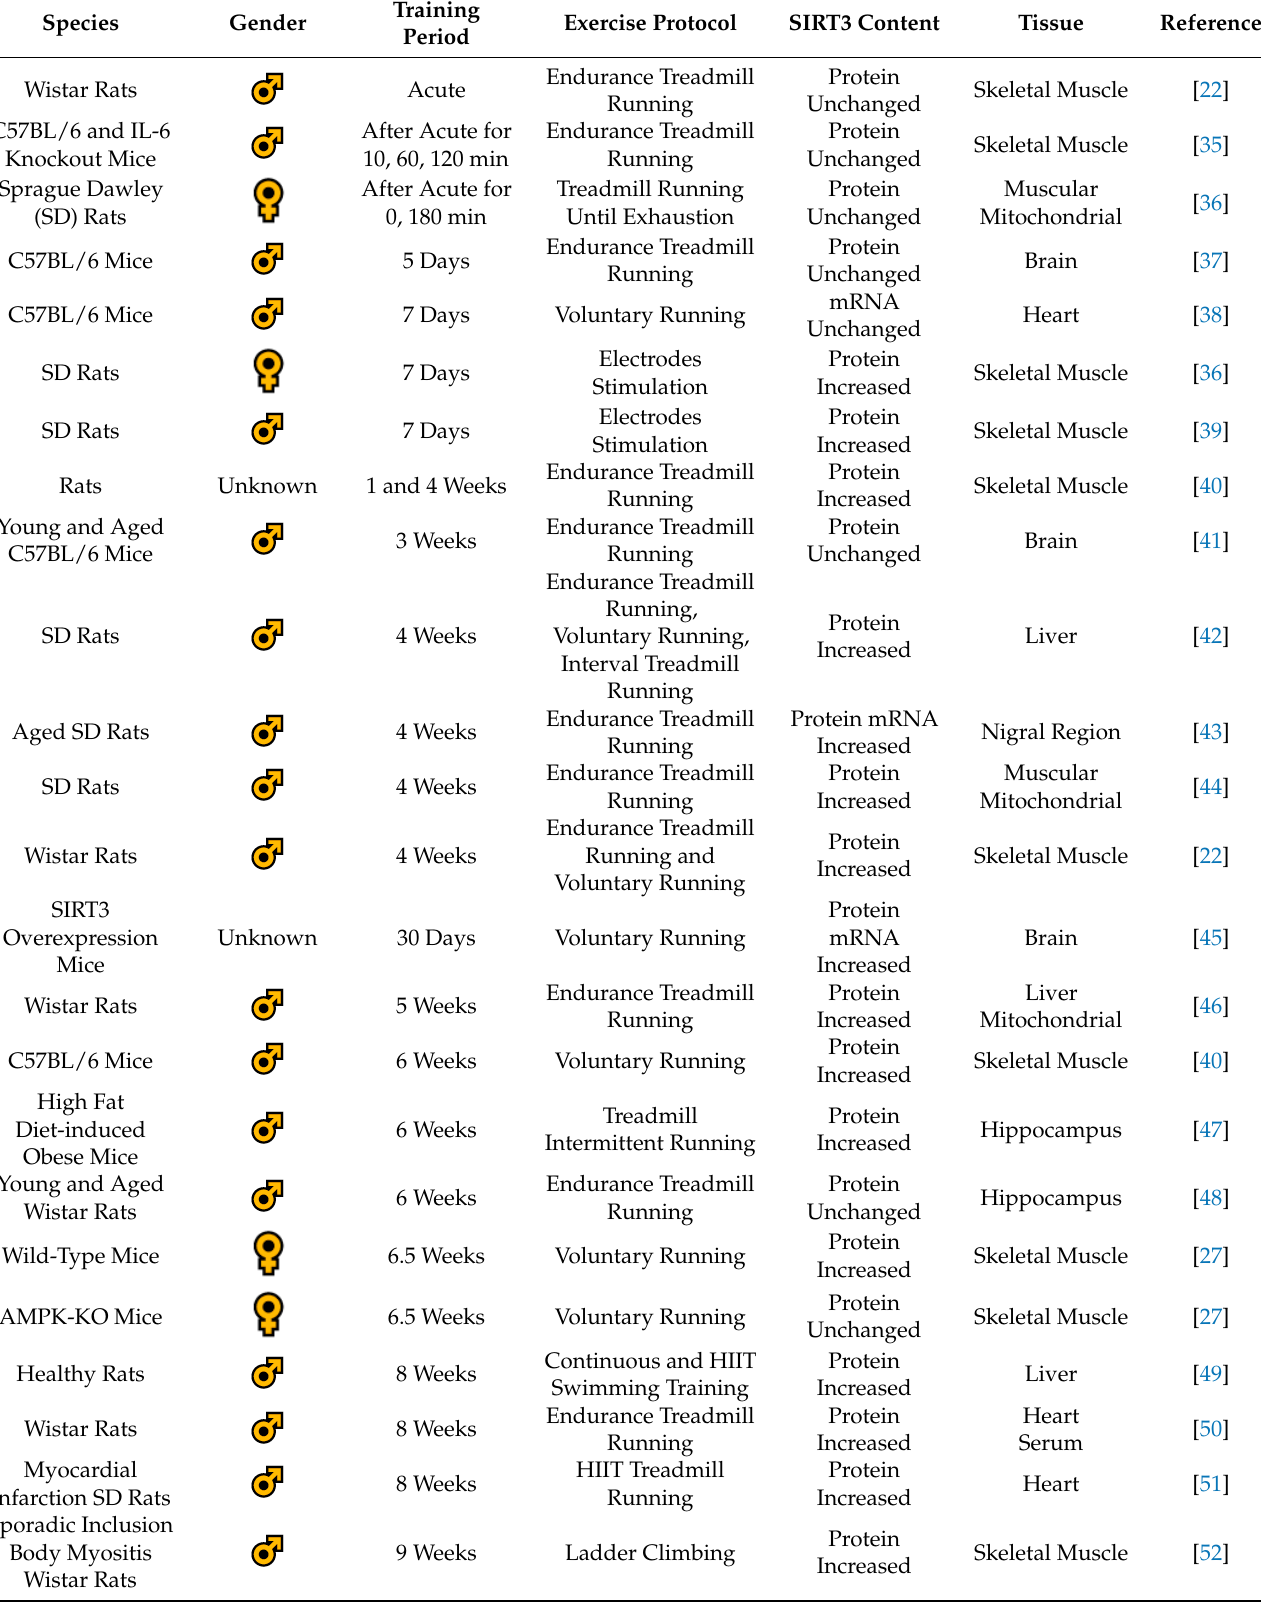
Table 2. The effects of exercises on SIRT3 expression in rodent studies.